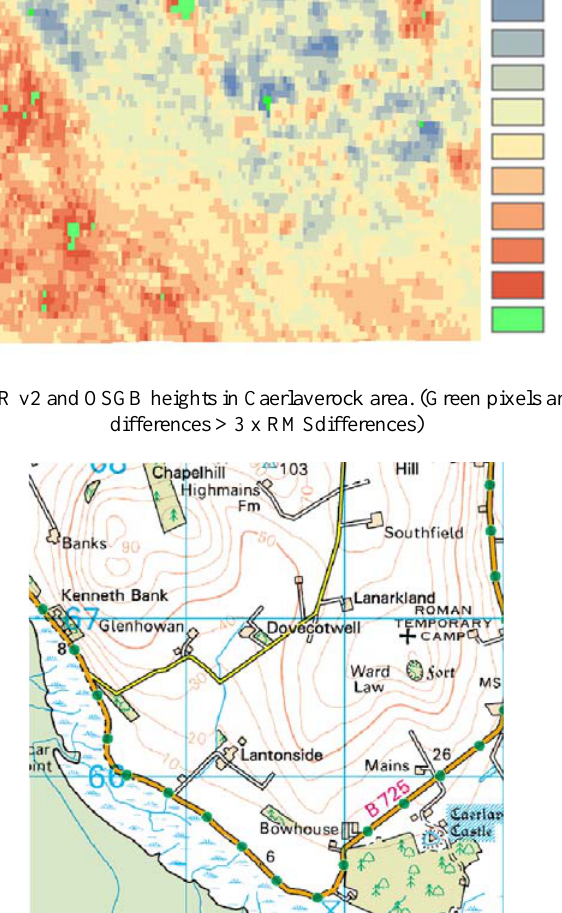
Fig 3c. Histogram of Differences, Caerlaverock, between ASTER v2 and OSGB terrain models Largest negative diff./error: -30.7m Largest positive diff./error: 39.9m Mean difference: 0.4m RMS diff.